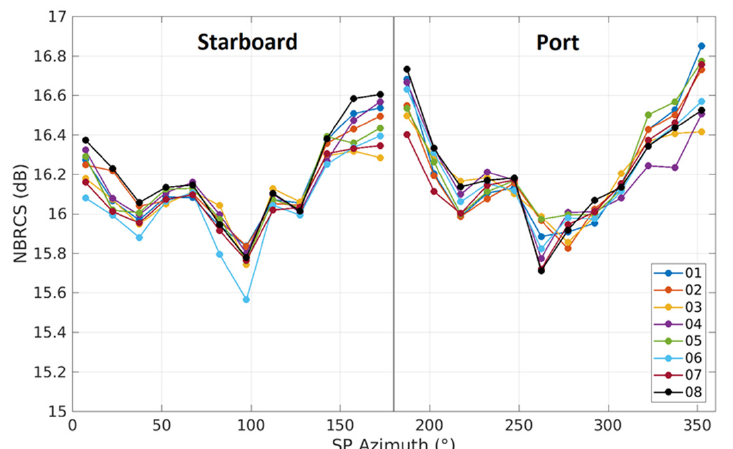
Figure 5. Dependence of NBRCS on azimuth at ERA-5 U10 ~7 m/s, for all GPS transmitters/SVNs, segmented by CyGNSS Flight Models (FM01-FM08).